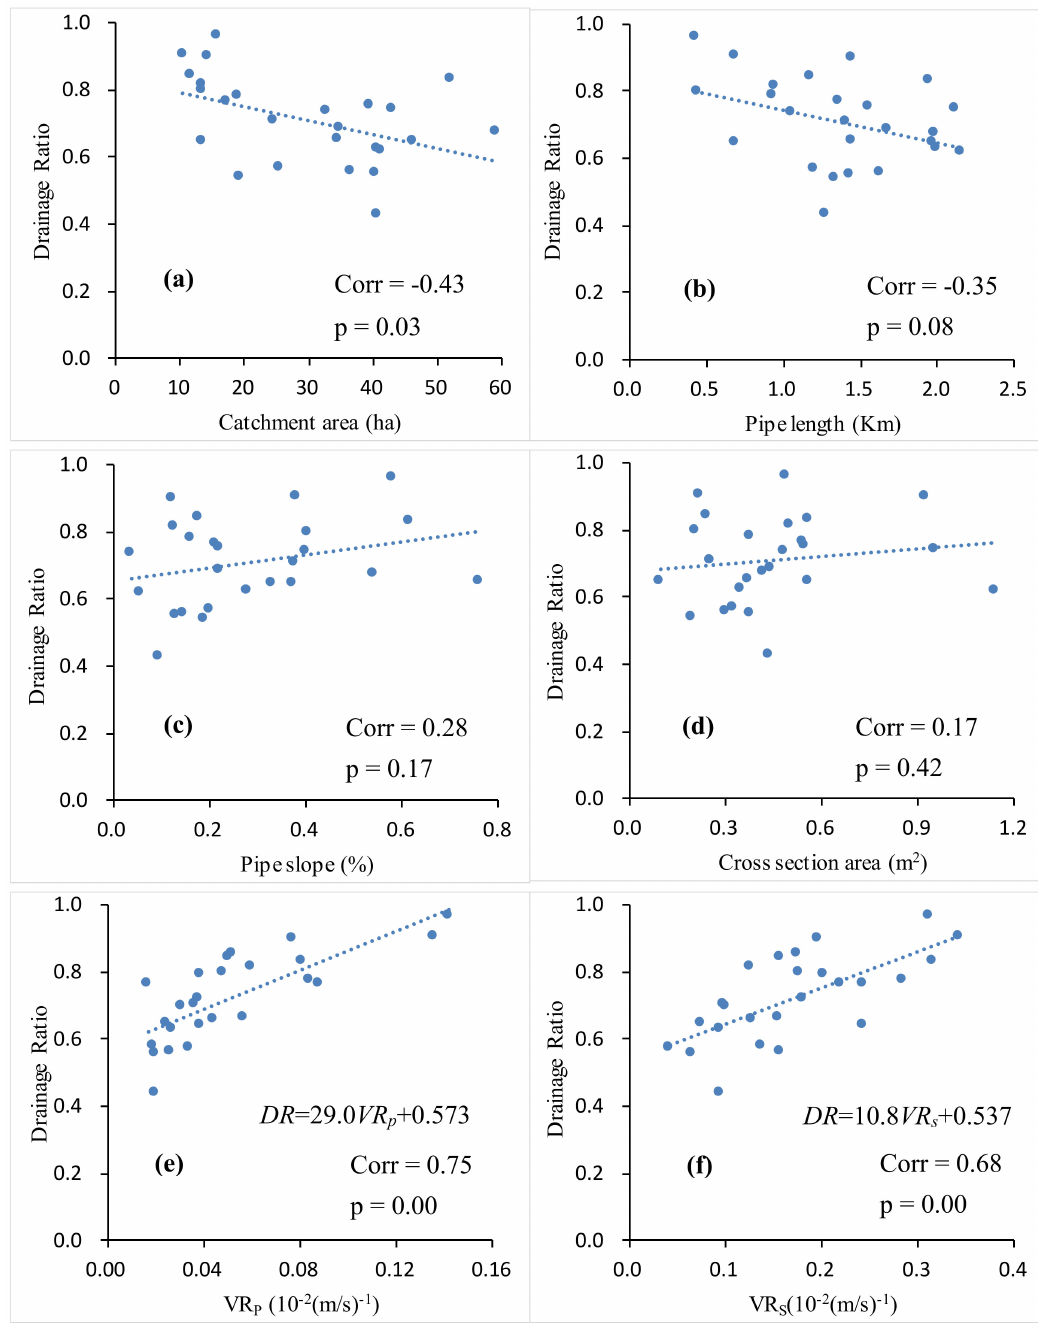
Figure 4. The scatter plots between the DR and six influential factors in the 25 drainage networks under the rainfall of a 100 year return period: catchment area ( a ), pipe length ( b ), pipe slope ( c ), pipe cross section area ( d ), Velocity Ratio ( VR) p from pipe ( e ), and VR s from land surface slope ( f ). The pipe slope and cross section area are calculated using Equation (6). “Corr” is the Pearson correlation coe ffi cient and “p” denotes the p-value in the statistical significance